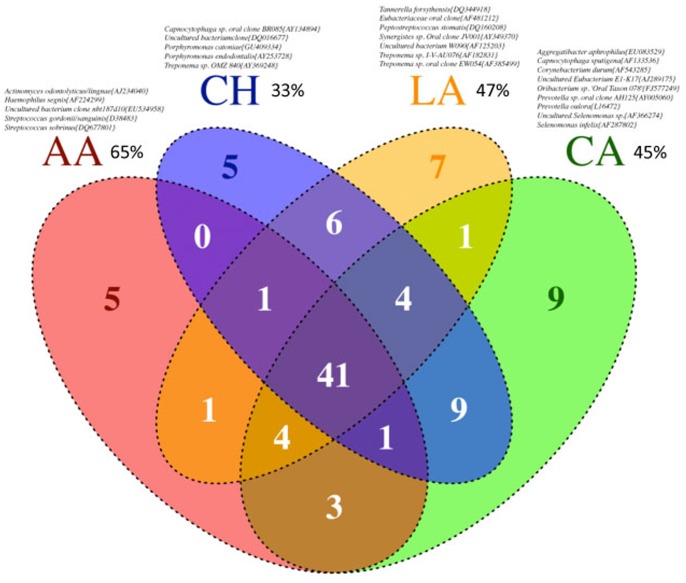
Venn diagram of ethnicity specific s-OTUs.These OTUs were identified based on presence/absence in each individual. The likelihood of discriminating between ethnicities using presence/absence of these s-OTUs is shown in parenthesis. The mere presence of these ethnicity-specific consortia was capable of identifying an individual’s ethnicity better than chance.